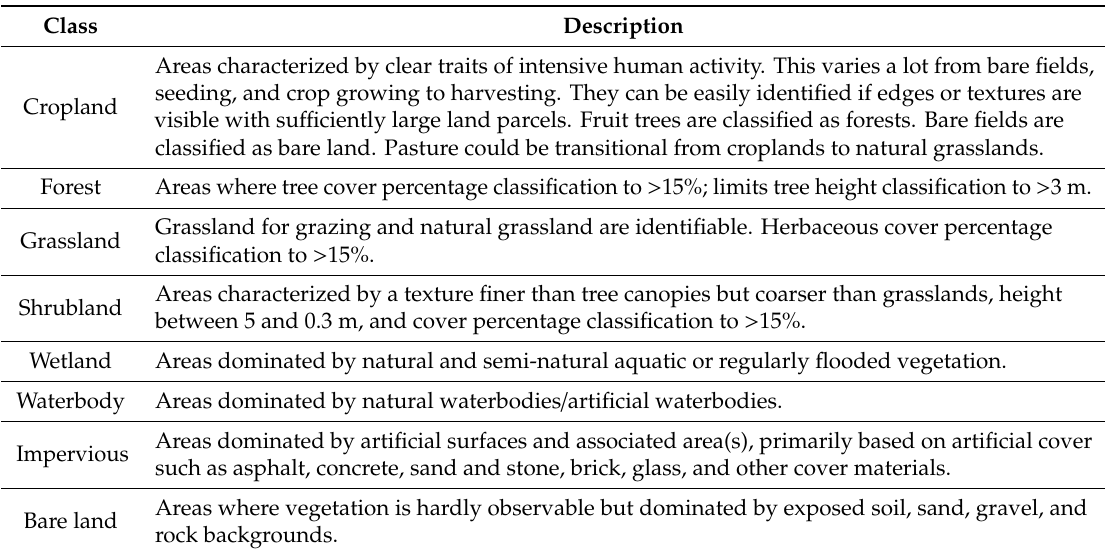
Table 1. Descriptions of land cover classes included in this